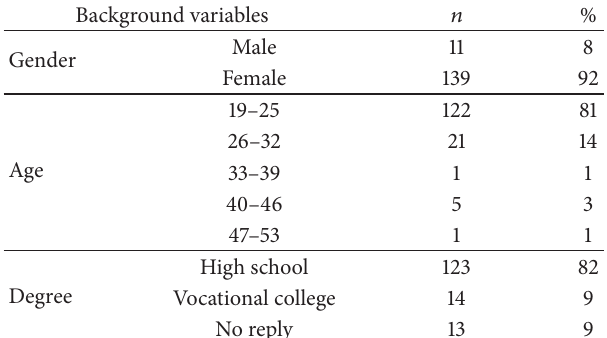
Table 1: Background